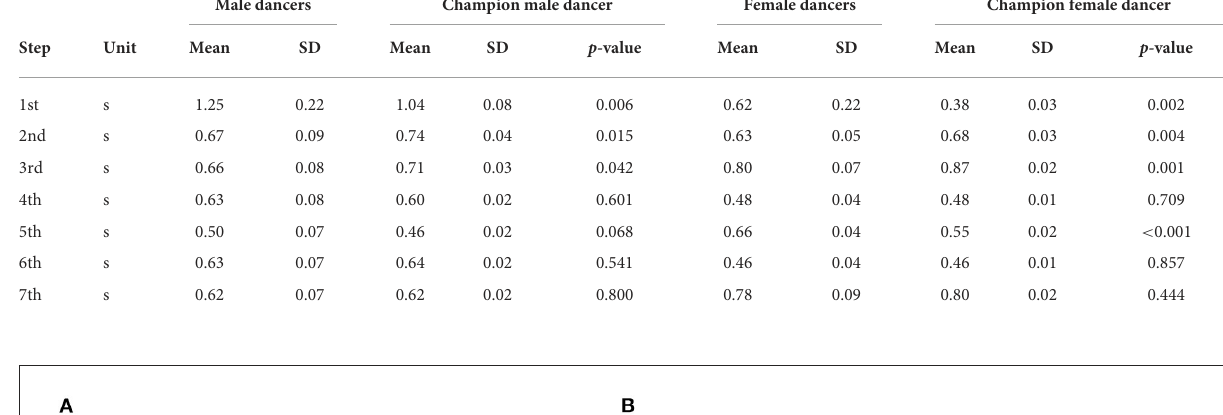
TABLE 3 Duration of each step for the champion male and female dancers and the control group male and female dancers during the spin movement. Male dancers Champion male dancer Female dancers Champion female dancer